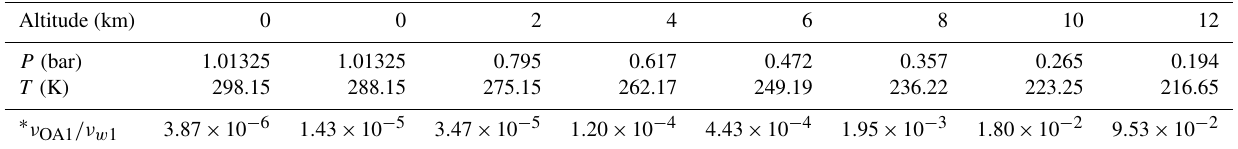
Table 5. Relative rate of SO 3 hydration reaction catalyzed by OA and by water at different altitudes. Altitude